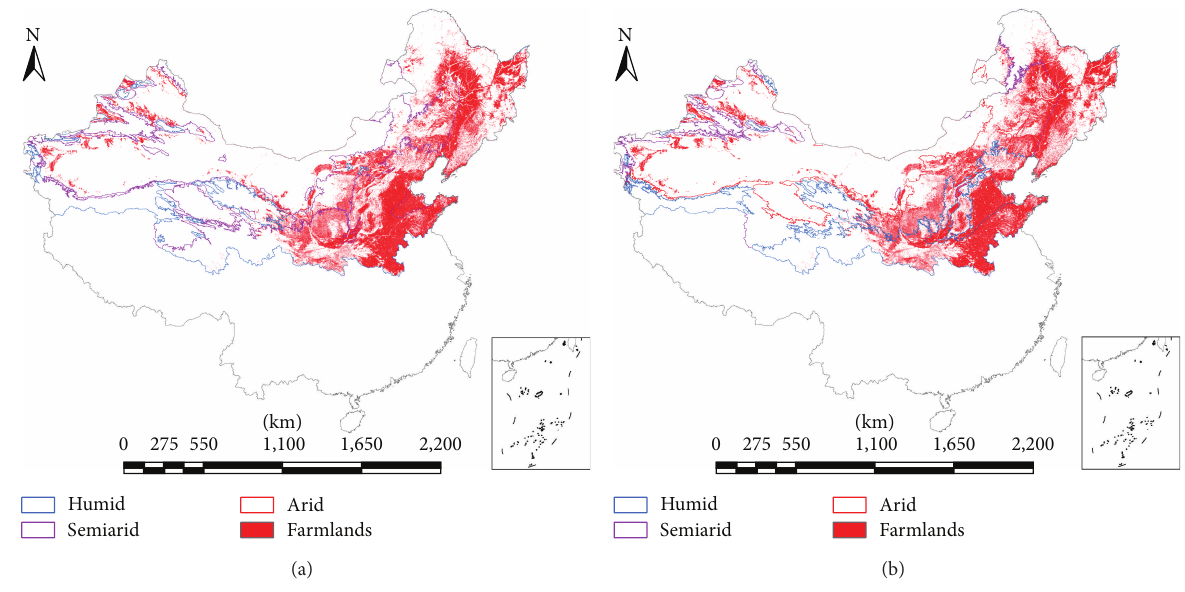
Figure 4: Farmland in northern China: (a) the late 1980s and (b) 2008. Table 3: Conversion between farmland and other land-use categories from the late 1980s to